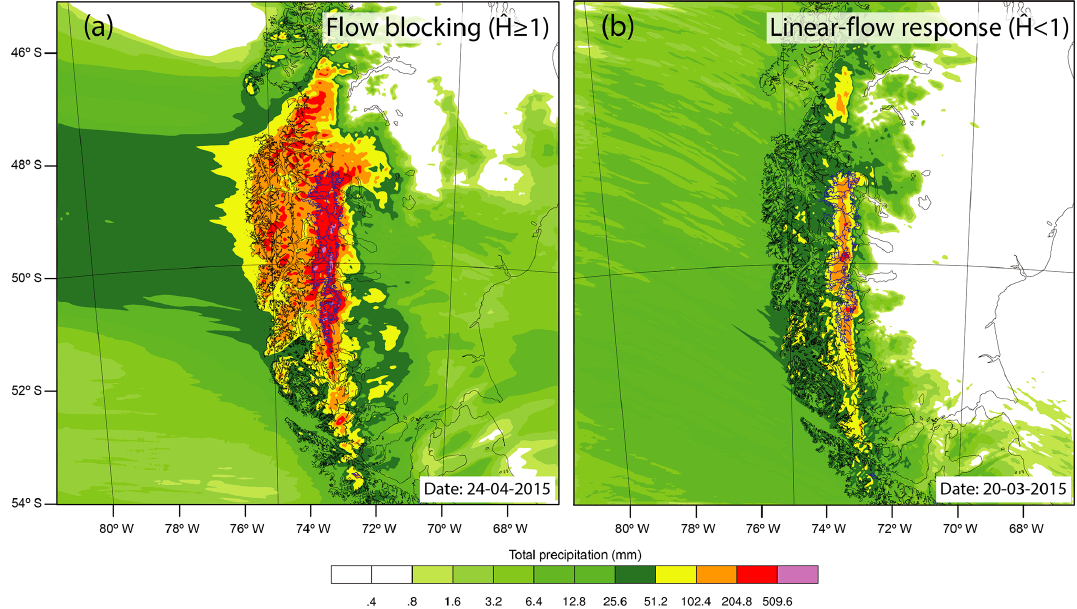
Figure 8. Total precipitation sums (3d) over the SPI and NPI from WRF for different flow regimes. (a) Nonlinear-flow response with enhanced precipitation in the Precordillera range and (b) linear-flow response with strong localized precipitation along the western slopes of the